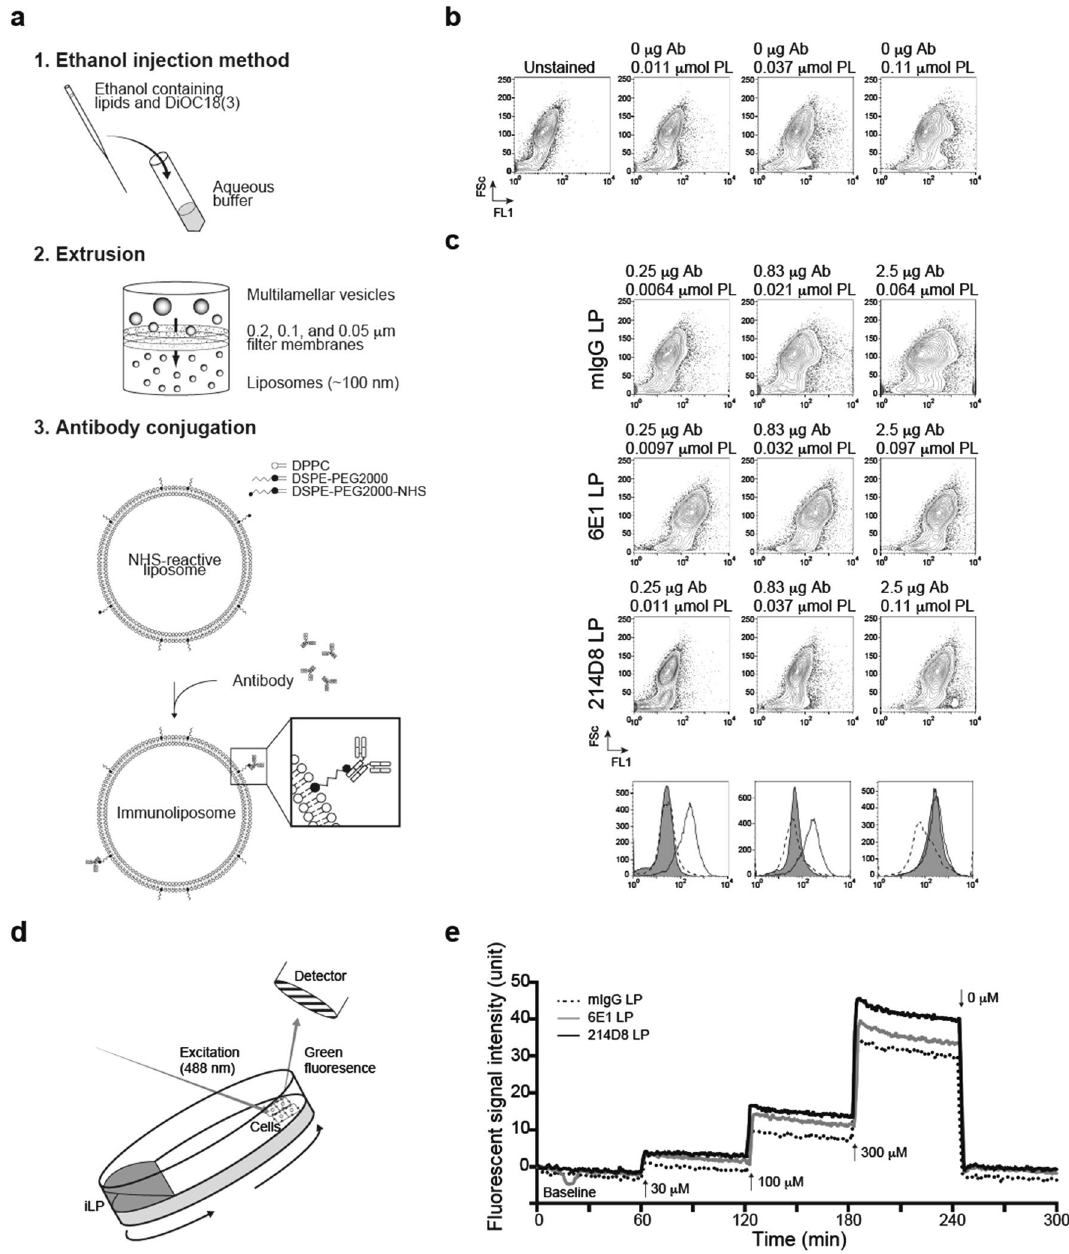
Figure 4. Antigen-specific binding of immunoliposomes. (a) Generation of immunoliposomes. Immunoliposome was generated through a three-step process: (1) the ethanol injection method, (2) extrusion through 0.05 µm, 0.1 µm, and 0.2 µm polycarbonate membrane filters, and (3) conjugation with antibody through crosslinking reaction with N -hydroxysuccinimide (NHS) ester. (b) Lack of immunoreactivity with liposome (LP) without antibody conjugation. At the phospholipid (PL) concentration equivalent of containing 0.25 µg, 0.83 µg, 2.5 µg antibody (Ab), liposome without antibody conjugation did not demonstrate reactivity against A172 cells. Representative results of duplicate independent experiments. (c) Immunoreactivity with immunoliposomes. A172 cells were tested by staining with control mIgG-conjugated (dotted white), 6E1-conjugated (white) or 214D8-conjugated liposomes (gray). Data of FITC fluorescent intensity (FL1) were indicated as histograms. Representative results of duplicate independent experiments. (d) Schematic diagram of measuring K D values of immunoliposomes. LigandTracer allows real-time quantification of fluorescently labeled immunoliposome binding to immobilized cells. (e) Representative diagram of K D measurement. Baseline, association phase, and dissociation phase through addition or subtraction of immunoliposomes were measured. Representative results of triplicate independent